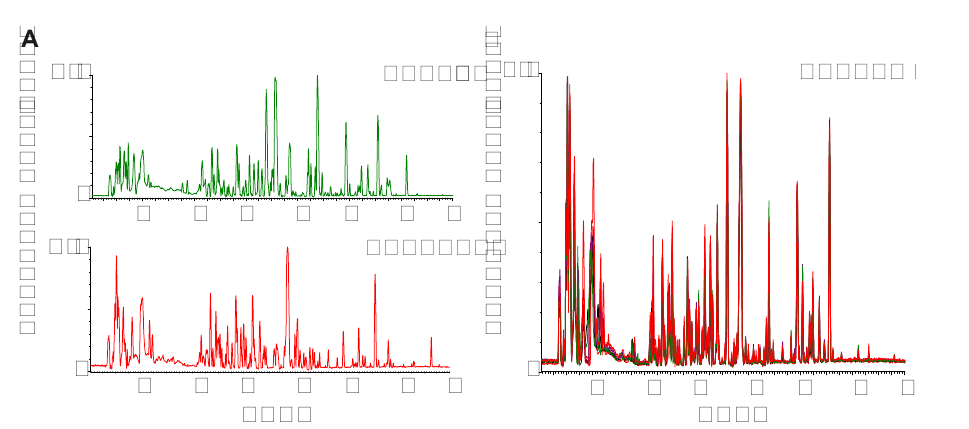
Figure 2. BPI chromatogram of urine samples. ( A ) Representative BPI chromatogram of urine samples from subjects with and without type 2 diabetes (T2D). ( B ) Overlap of QC samples BPI chromatogram shows that the retention time for major peaks were found to be stable throughout the whole analysis.